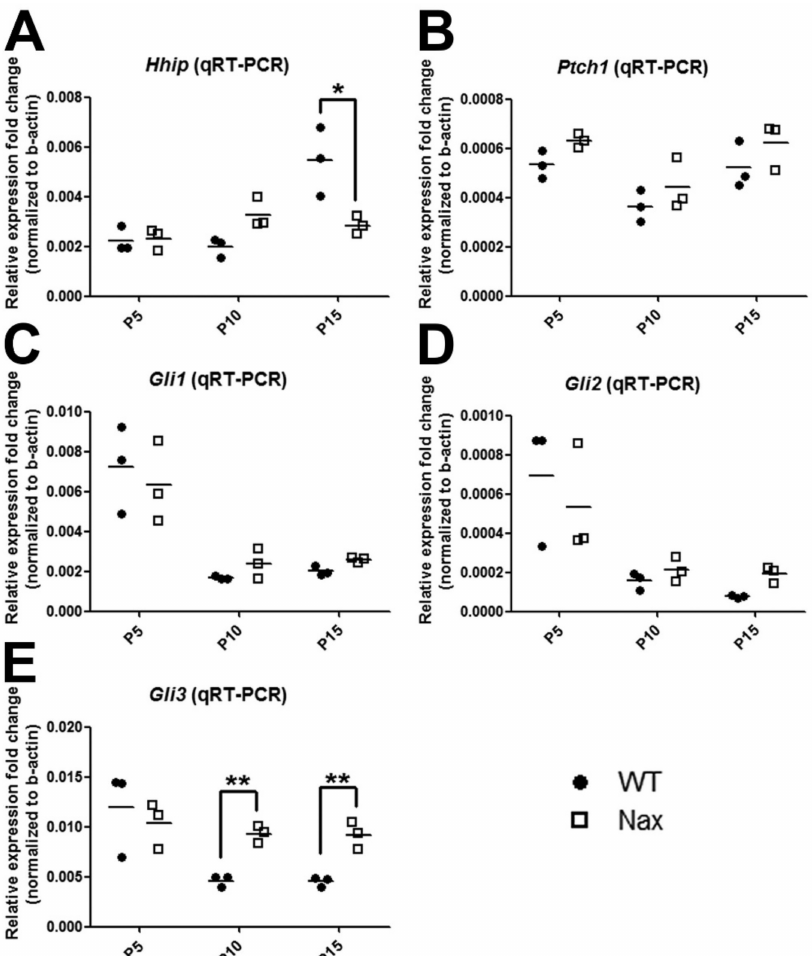
Figure 6. mRNA transcription levels of Hhip , Ptch1, and Gli1–3 in wt and nax cerebella . ( A ) Based on RT-qPCR, Hhip gene expression in wt and nax cerebella was comparable at P5 and P10, which are the most critical days for GC proliferation. In wt mice, expression appears to be increased at P15, whereas it remained at the same level in nax animals (* p < 0.05 compared to wt). ( B ) No differences in Ptch1 expression were observed between wt and nax cerebella; expression levels did not significantly change over time (P5–15). ( C ) As compared to P5, Gli1 gene expression decreased over time at P10 and 15; no significant differences were observed between the nax and wt cerebellum at any time point. ( D ) Gli2 mRNA expression decreased over time in a similar fashion as for Gli1 ; no significant differences in Gli2 expression were observed between the nax and wt cerebellum. ( E ) Gli3 mRNA expression decreased over time in the wt cerebellum, in a similar fashion as for Gli1 and -2 , but was maintained high (same level as on P5) at P10 and 15 in the nax cerebella. Expression levels were significantly different between wt and nax at P10 (** p < 0.01) and 15 (** p < 0.01). The data in the graph are presented as the mean ± SEM, and statistical analysis was performed using an unpaired t